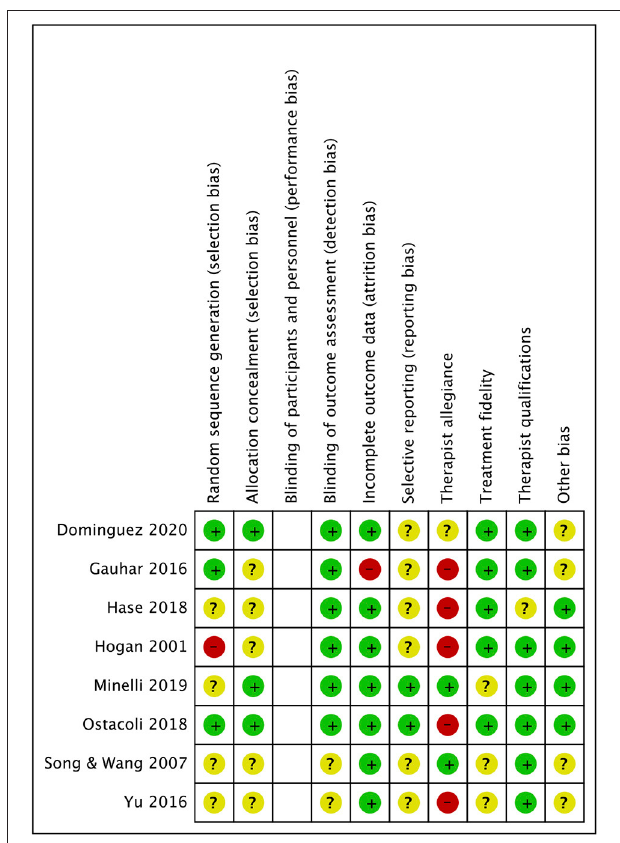
FIGURE 2 | Risk of bias summary.